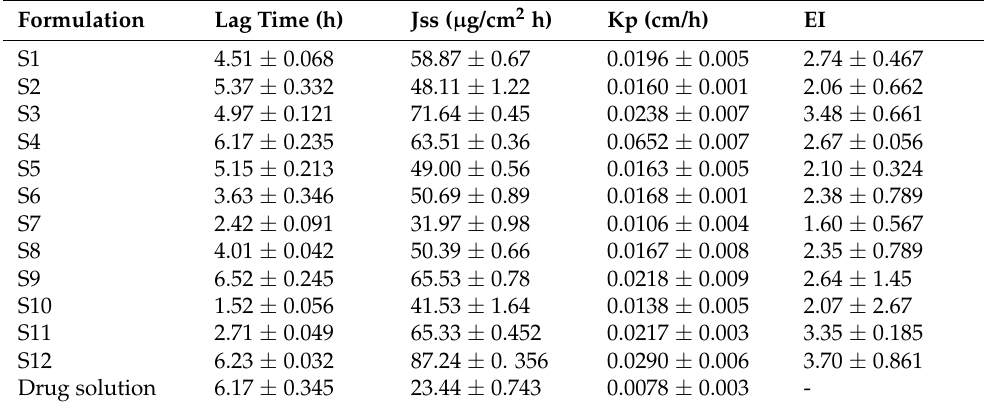
Table 3. Ex vivo permeation parameters of DNa-BSVCs versus DNa solution.